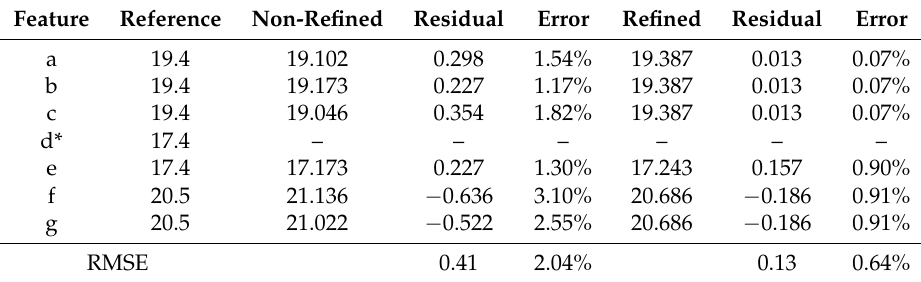
Table 3. Accuracy assessment of the height measurement of a video frame cut (unit: m).